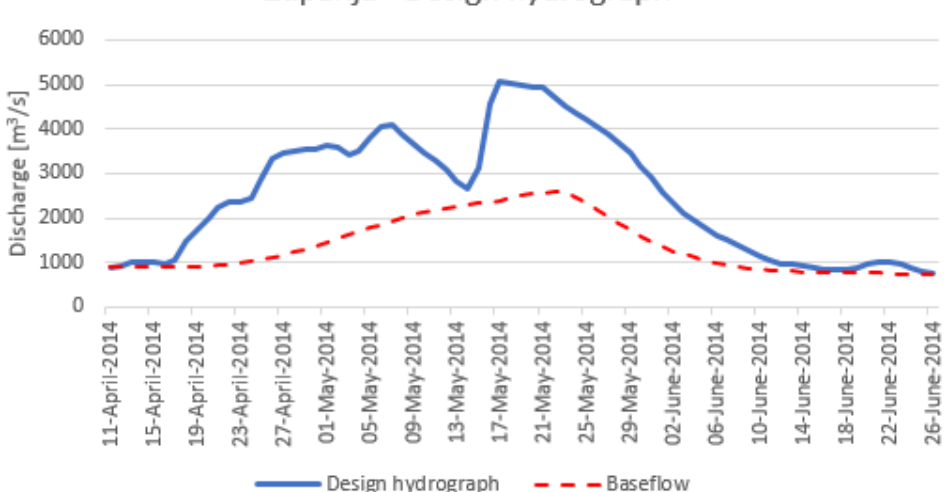
Figure 5. Example of design hydrograph for the Zupanja GS on the Sava River that was constructed based on the measured AM flood hydrograph from the year 2014. The surface runoff volume corre- sponds to the V 100 (i.e., 7454 × 10 6 m 3 ) while peak discharge corresponds to Q 100 (i.e., 5060 m 3 /s). At the same time, the design hydrograph corresponds to the bivariate return periods T AND and T OR 256 years and 62 years, respectively.